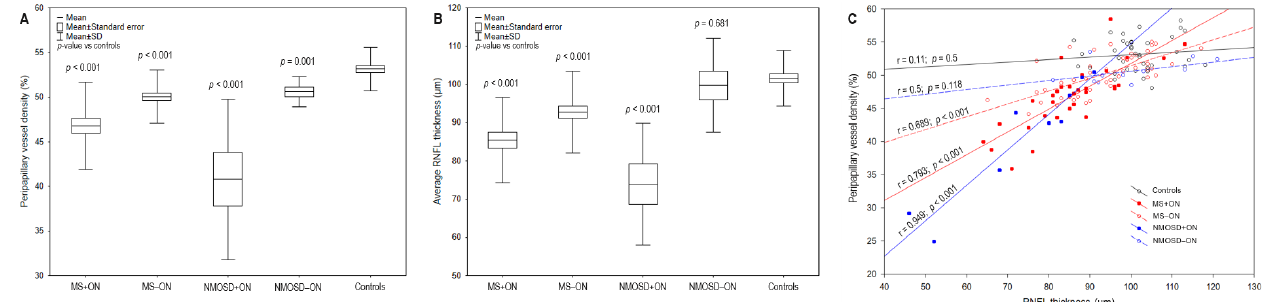
Figure 2. The boxplots demonstrate the average peripapillary vessel density ( A ) and RNFL thickness ( B ) of MS+ON, MS−ON, NMOSD+ON, NMOSD−ON, and controls. The scatterplot presents the correlation between RPC and RNFL parameters of all groups ( C ). MS =multiple sclerosis; NMOSD = neuromyelitis optica spectrum disorder; ON = optic neuritis; RNFL = retinal nerve fiber layer; RPC = radial peripapillary capillaries; SD = standard deviation. Table 2. Baseline spectral-domain OCT and OCT angiography results of patients and controls.